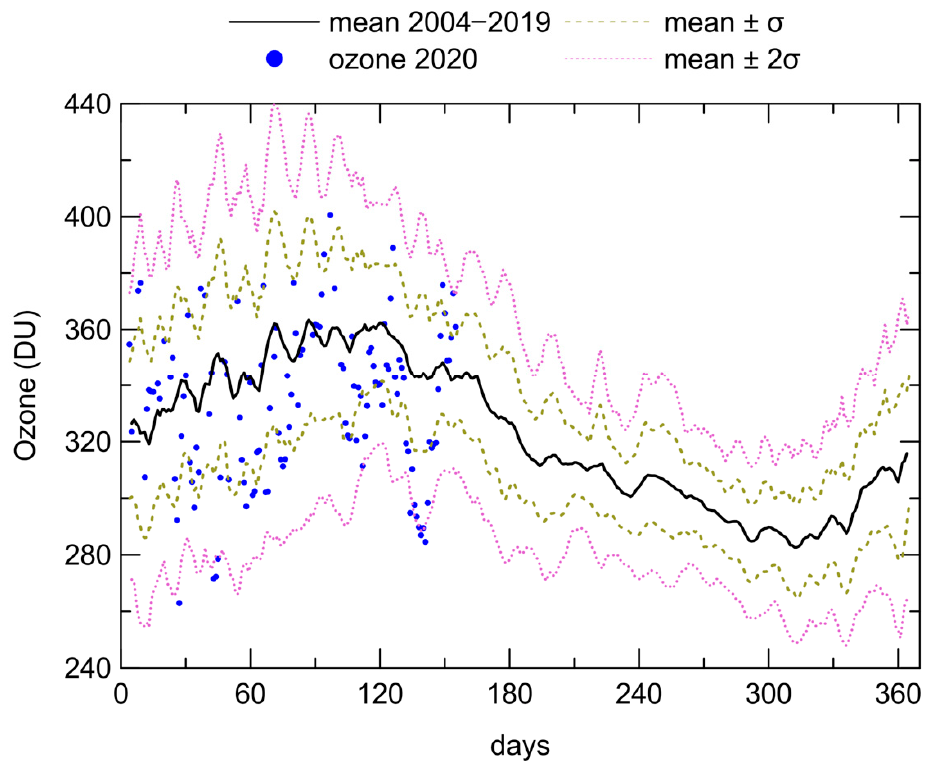
Figure 1. Daily average TOC at Athens, retrieved by BRS, for the period 2004–2019; 1 and 2 σ variations along with 2020 measured TOC values are also shown.